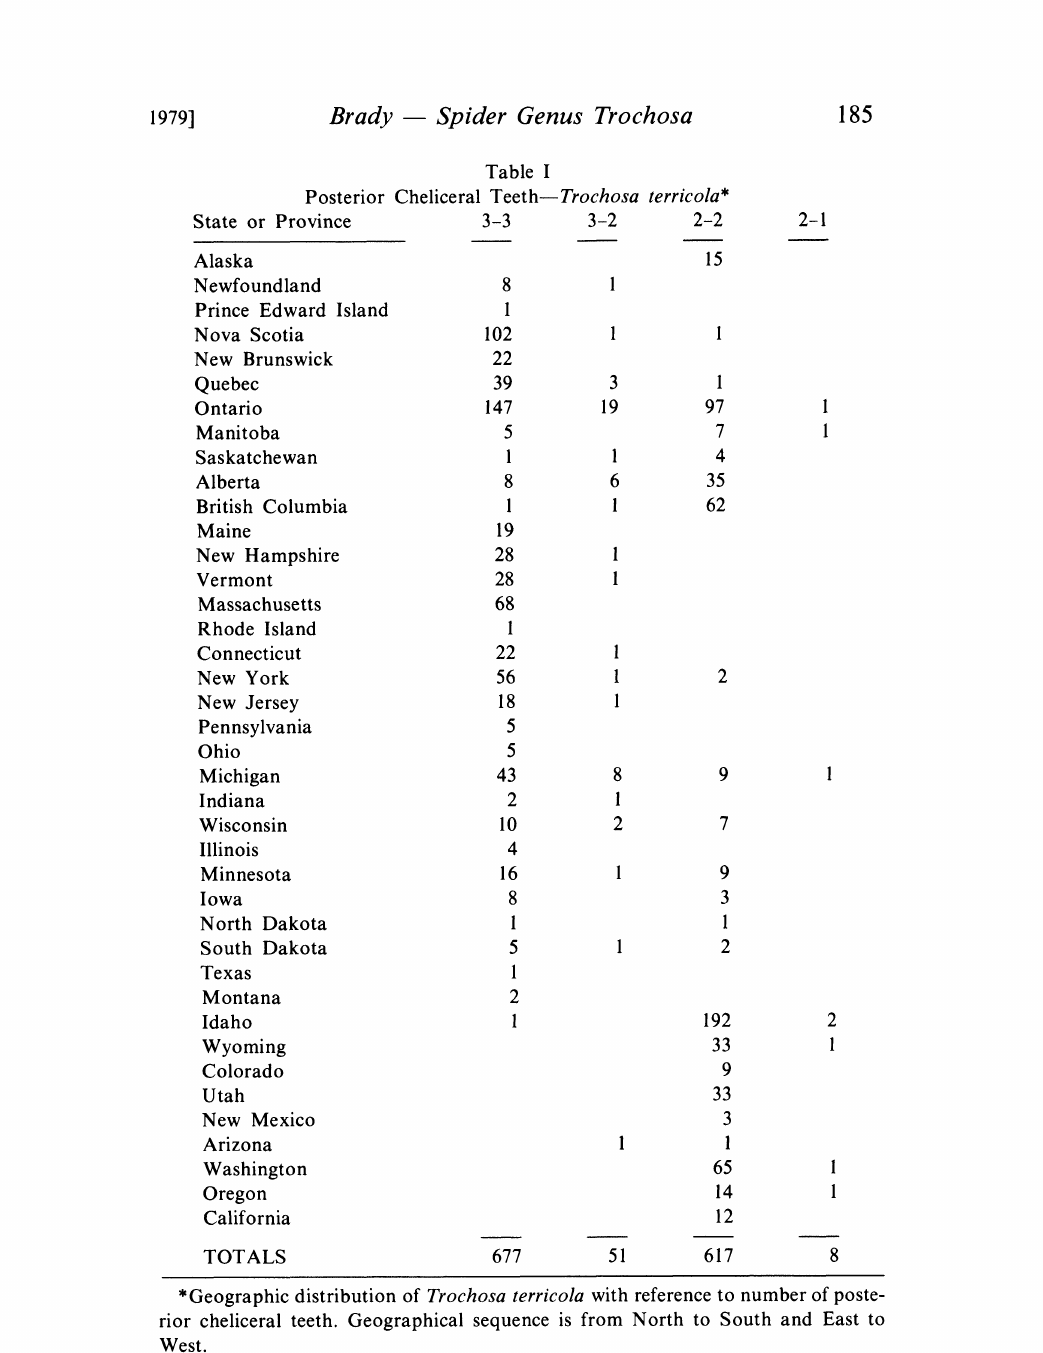
Posterior Cheliceral Teeth--Trochosa terricola* State or